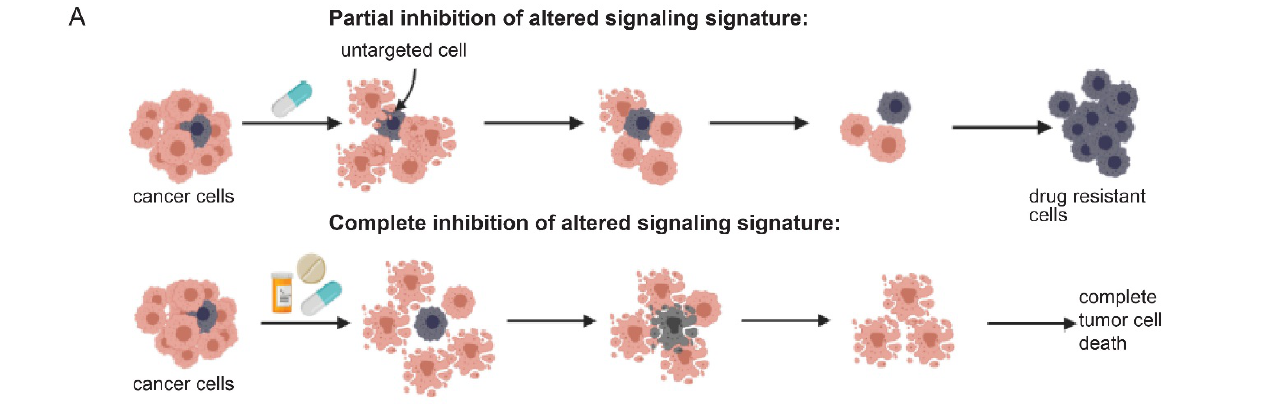
Figure 3. Development of resistance to various therapies. ( A ) The development of resistance to different types of therapies is shown in the illustration. Cells were treated for 72 h, allowed to regrow, and checked for survival; ( B ) In MDA-MB-468 cells, regrowth was detected when the cells were treated with Er monotherapy, Er + Tr, and also the combination predicted for MDA-MB-231 (Tr + 2DG), but not in the cells treated with the PaSSS-based therapy, Er + Tr + Tam; ( C ) Survival of MDA-MB-468 cells after the treatment with Er + Tr for 72 h. Cells were allowed to regrow until day 14, then Tam was